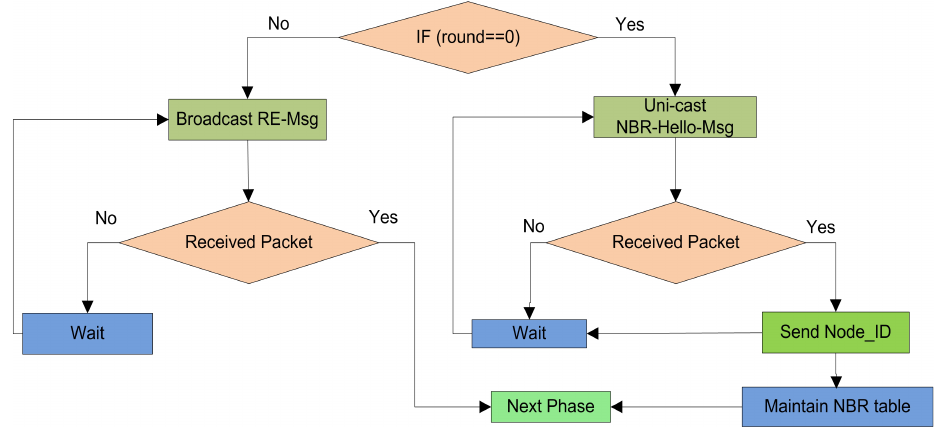
Figure 3. The pipeline of neighbor